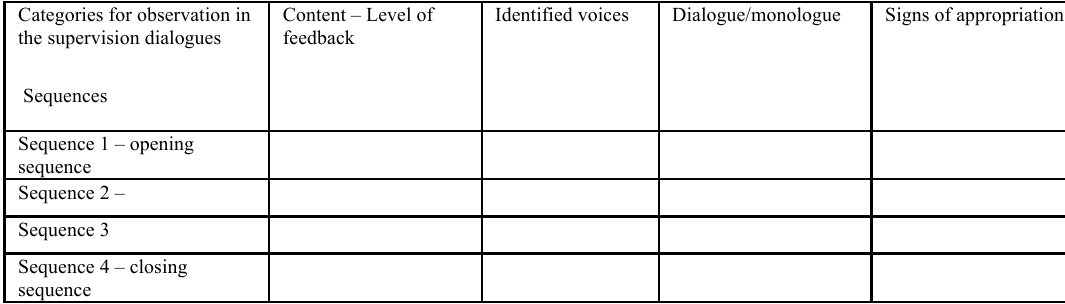
Table 4: Illustration of research